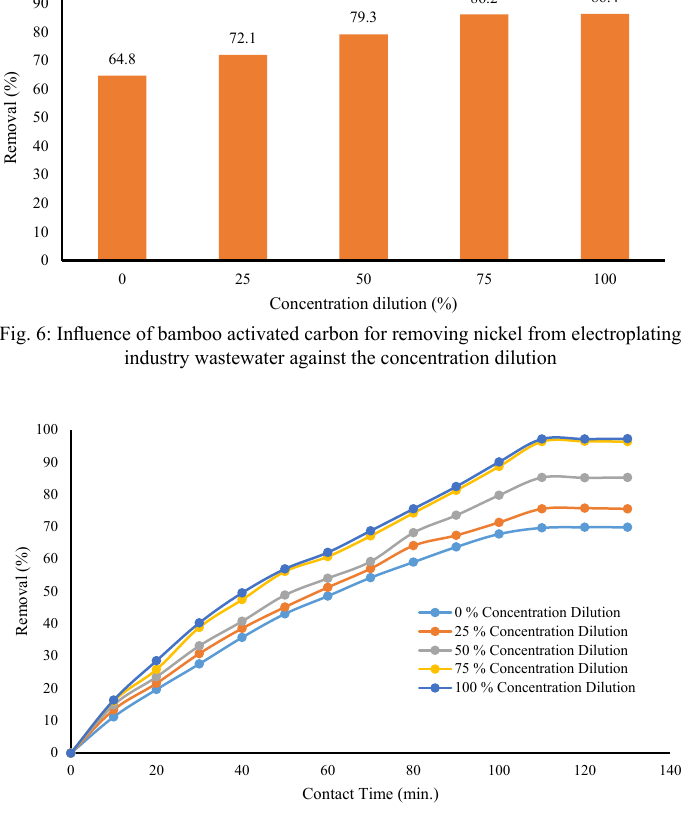
Fig. 7: Influence of bamboo activated carbon for removing nickel ion from electroplating industry wastewater at an optimum process parameters values against various contact time with the pH of 5.5